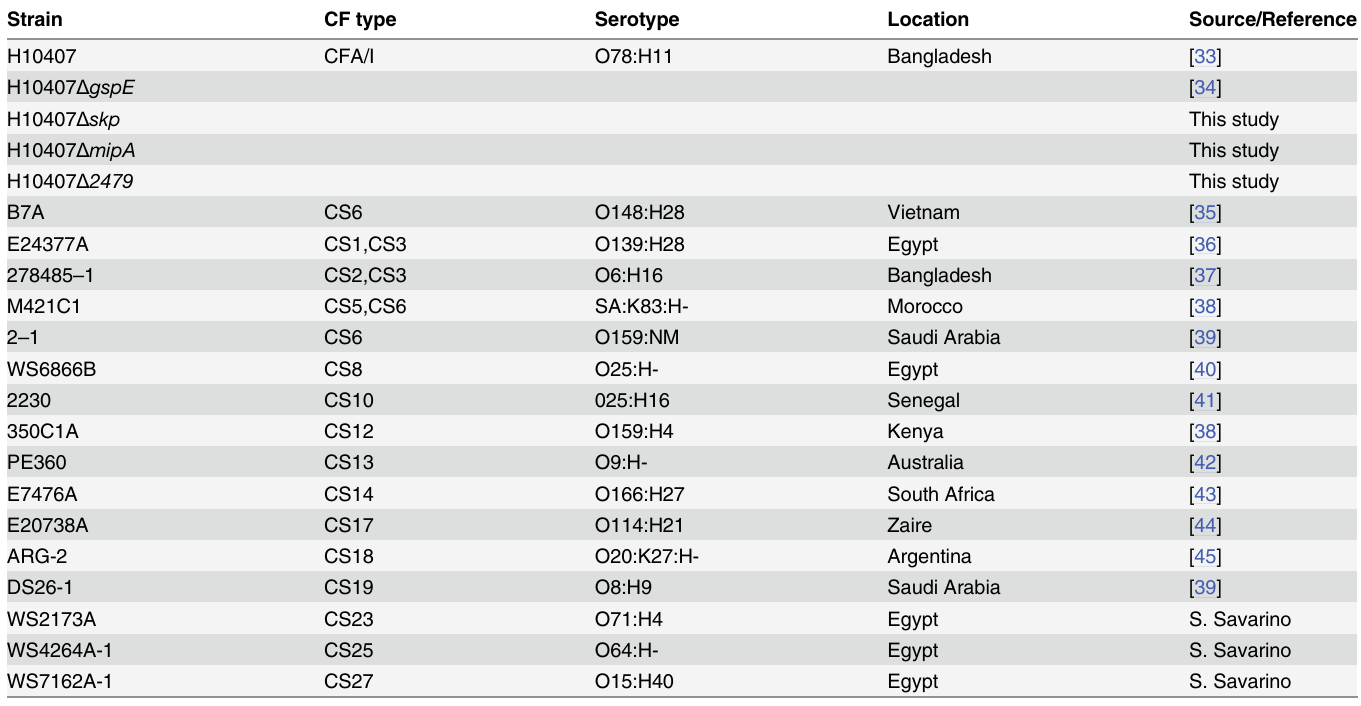
Table 1. ETEC strains used in this